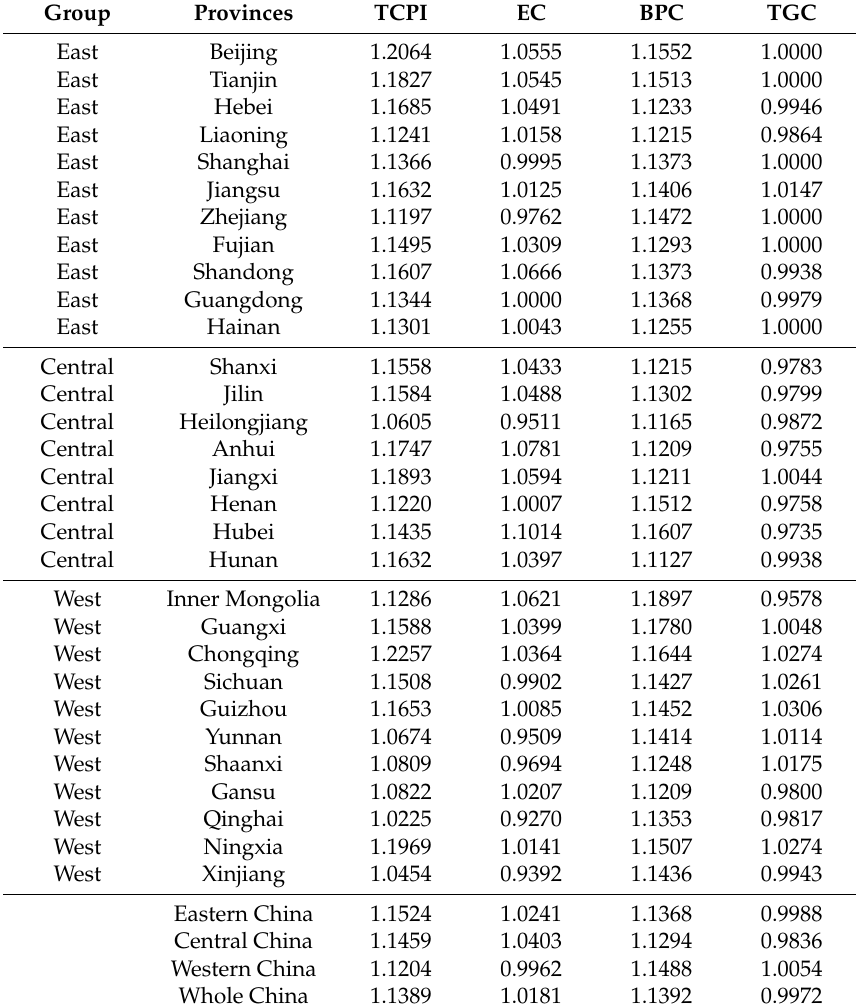
Table 3. Carbon emission performance and its decomposition in